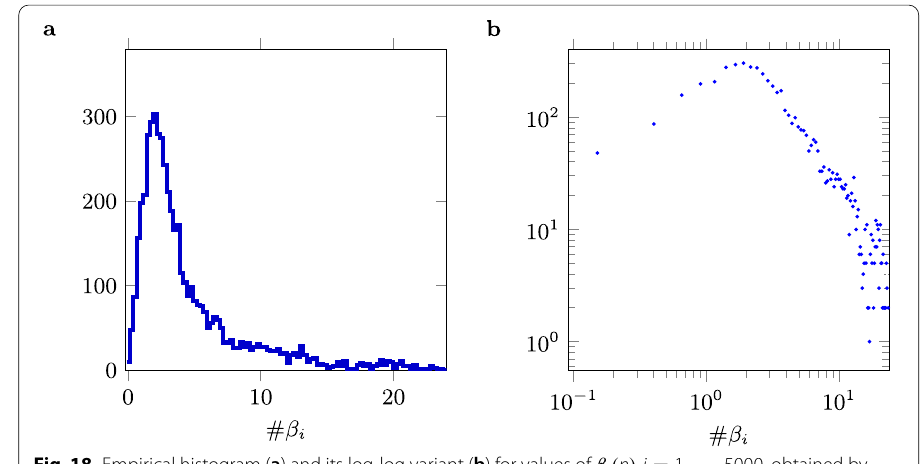
Fig. 18 Empirical histogram ( a ) and its log-log variant ( b ) for values of β i ( n ) , i = 1, ... ,5000 , obtained by simulating TC network of size n = 5000 . All intervals of length 0.25